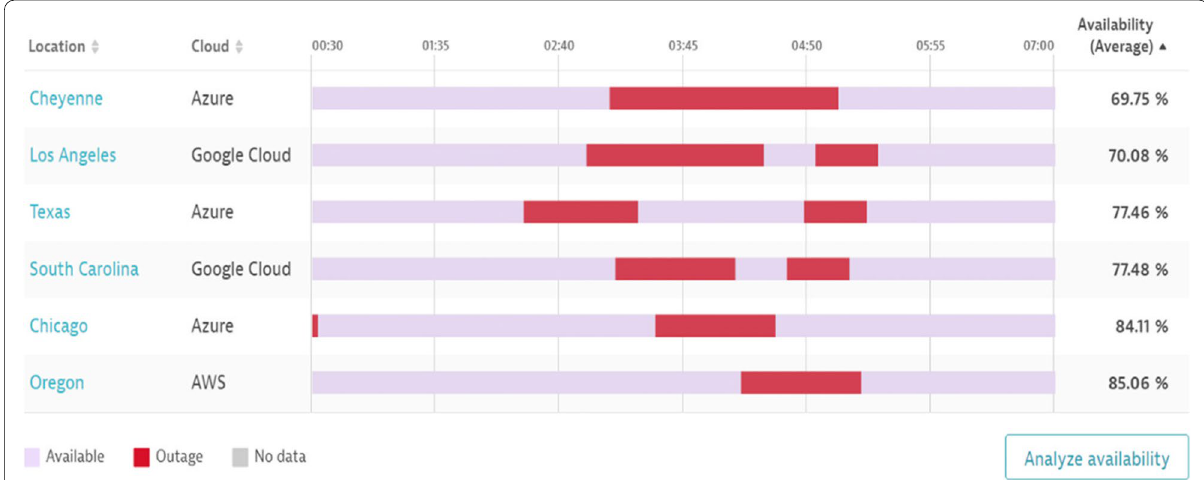
Fig. 23 Application availability split by geography of synthetic tests (Monolith)